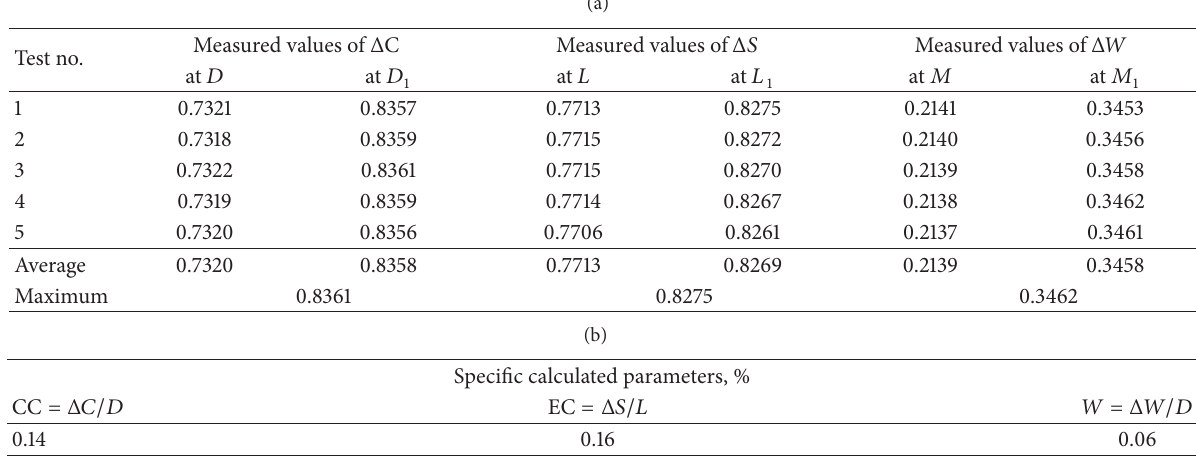
Table 7: The classification results of tile first specimen using new measurement method in